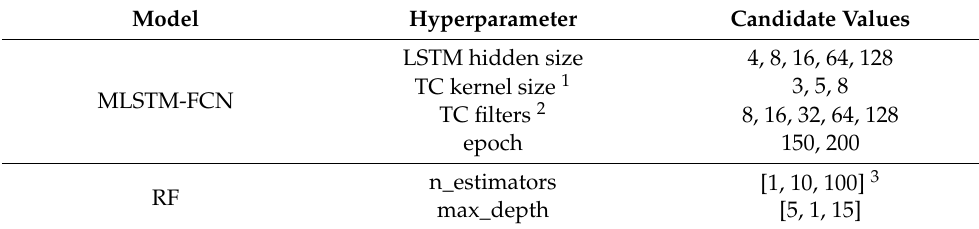
Table 1. The search hyperparameters combinations of MLSTM-FCN and